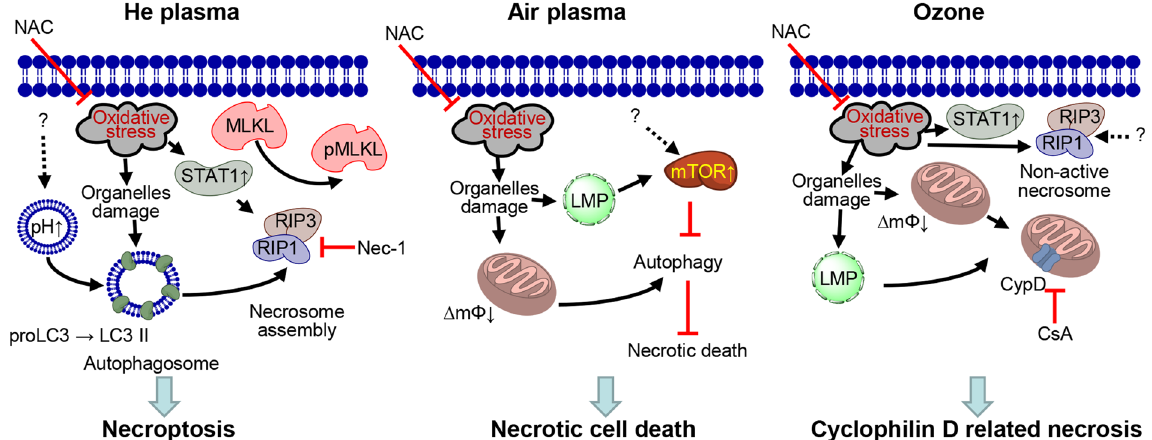
Figure 8. Scheme of district biochemical signaling activation in cells after stimulation with air, helium NTPs and ozone. LMP – lysosomal membrane permeabilization; ∆ m Φ – mitochondrial membrane potential; CsA – cyclosporin A; LMP – lysosomal membrane